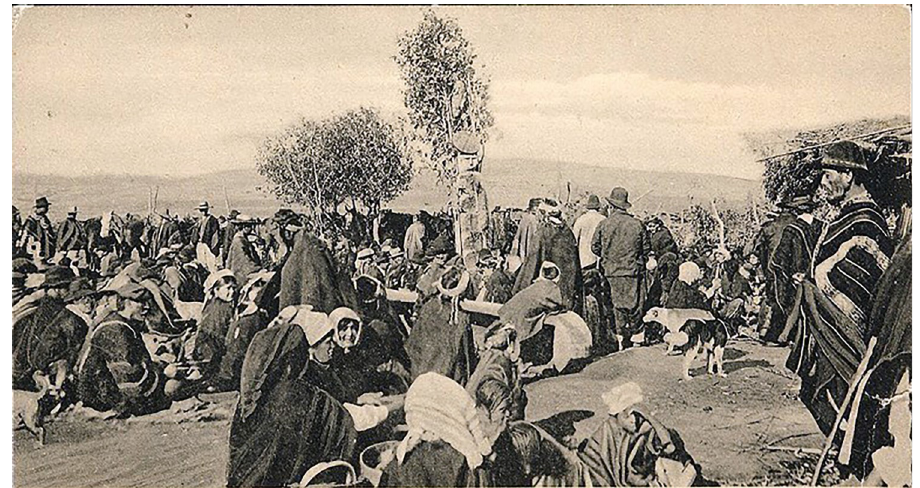
Fig 9. Construction of dug-out canoes in the chronicles of Virginia. Printed hand-coloured engraving by Theodor de Bry after John White, ca. 1590.